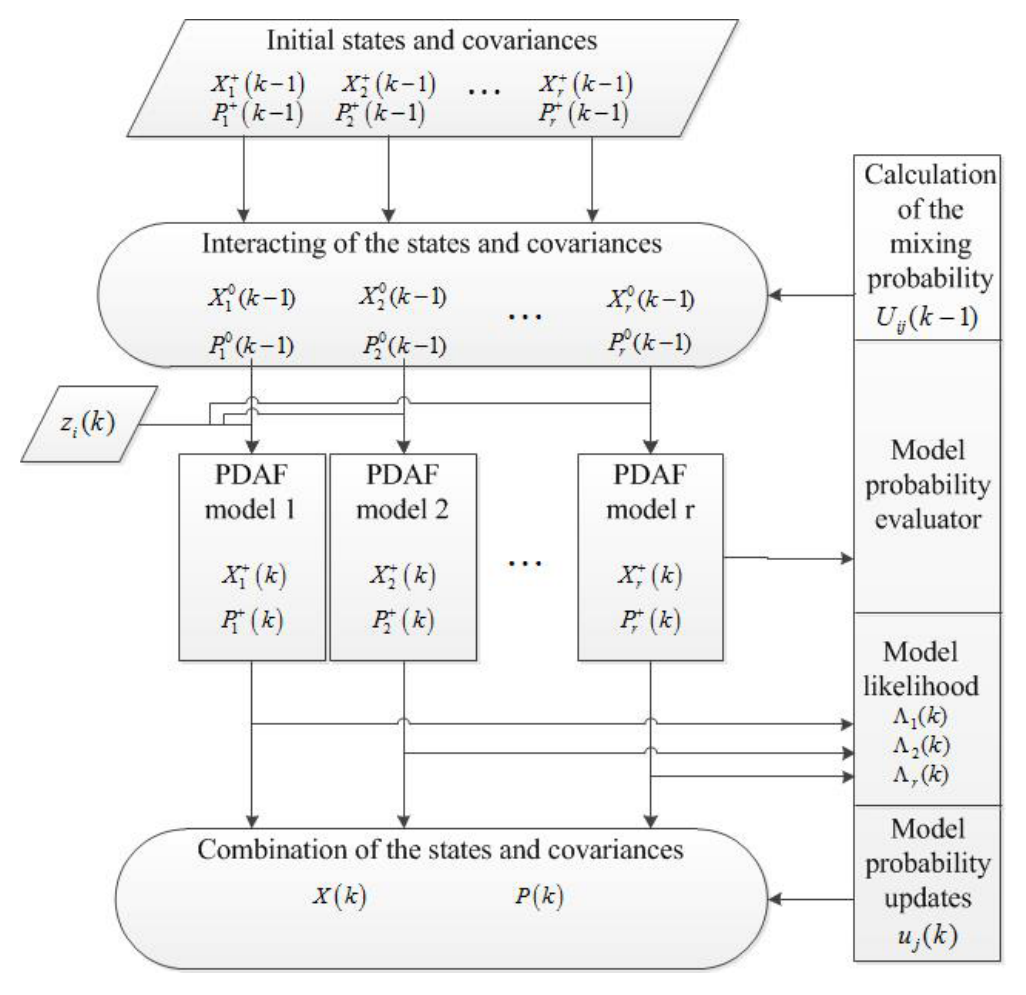
Figure 1. Flow chart of the IMMPDAF with three